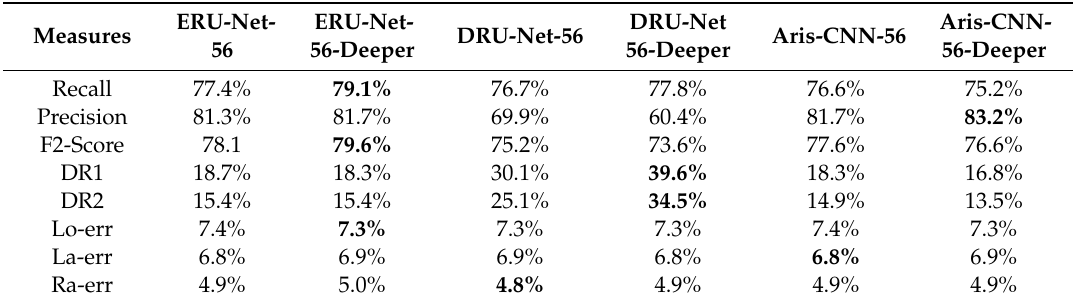
Table 3. The recognition results of models after deepening the network (bold in the table means the best results on this evaluation